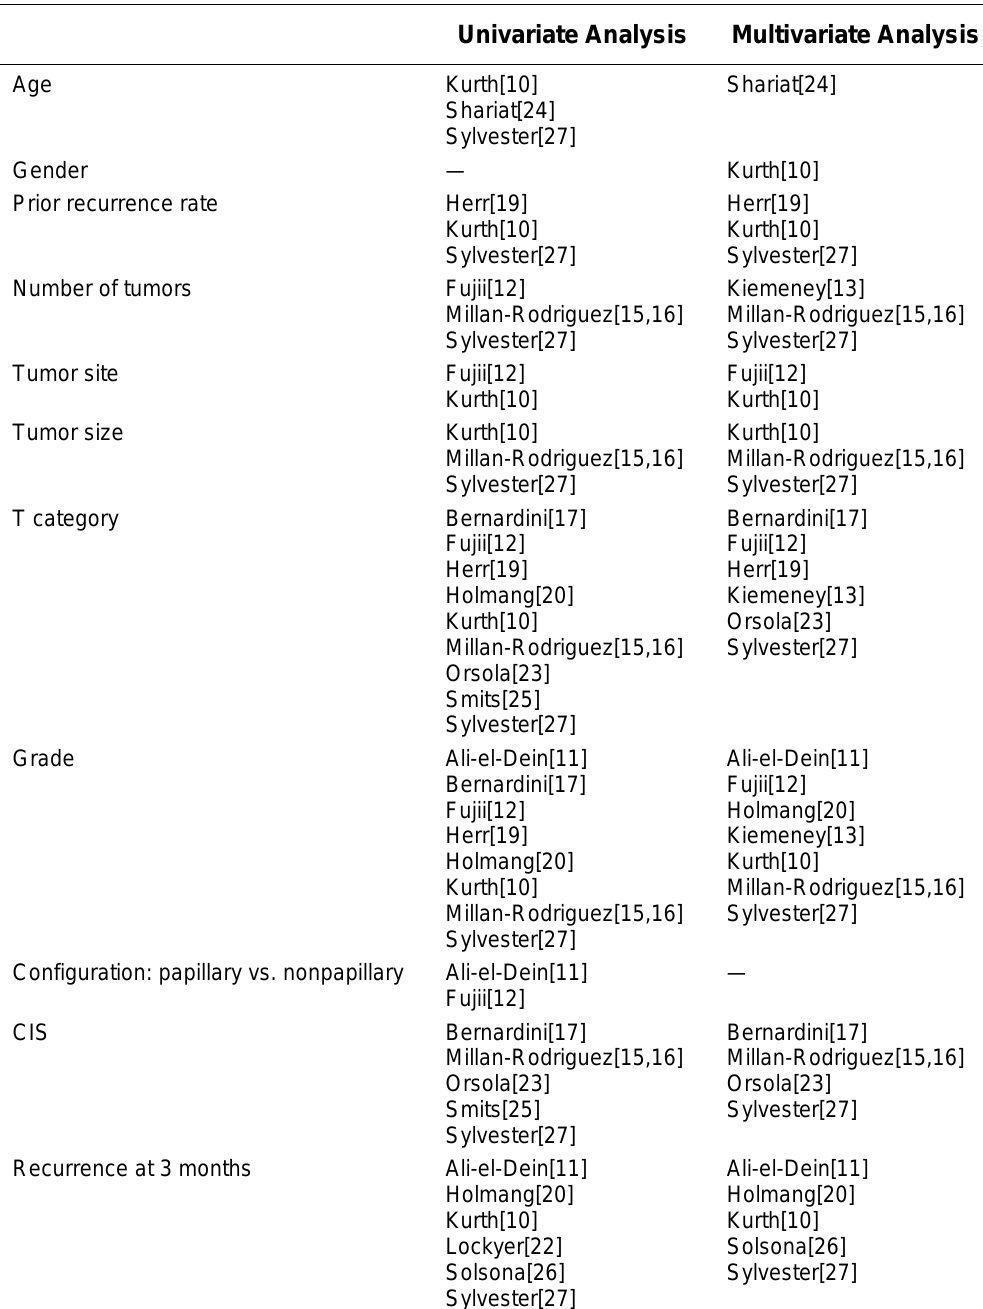
Prognostic Factors for Progression Univariate Analysis Multivariate